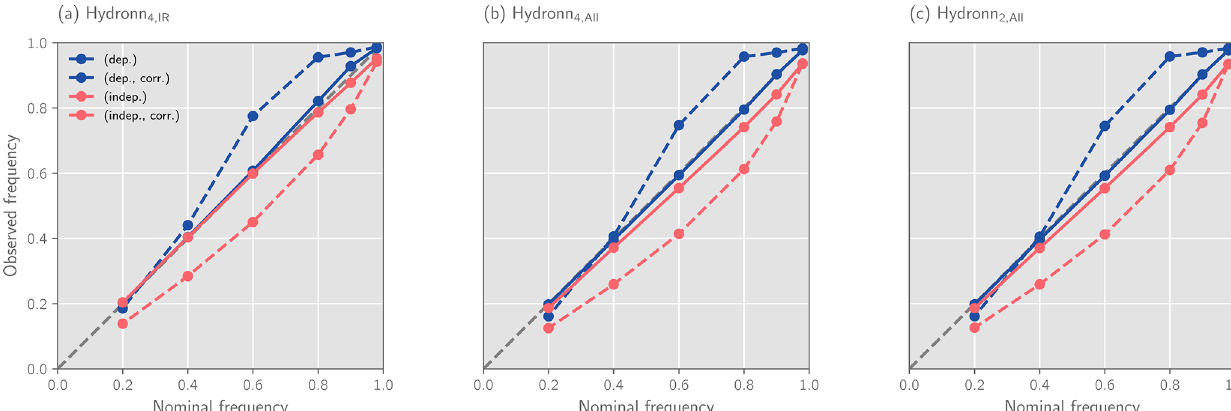
Figure 15. Calibration of the confidence intervals derived using the quantiles of the retrieval posterior distribution predicted by each Hydronn configuration for December 2020. The dashed grey line in the background shows the expected results for perfectly calibrated